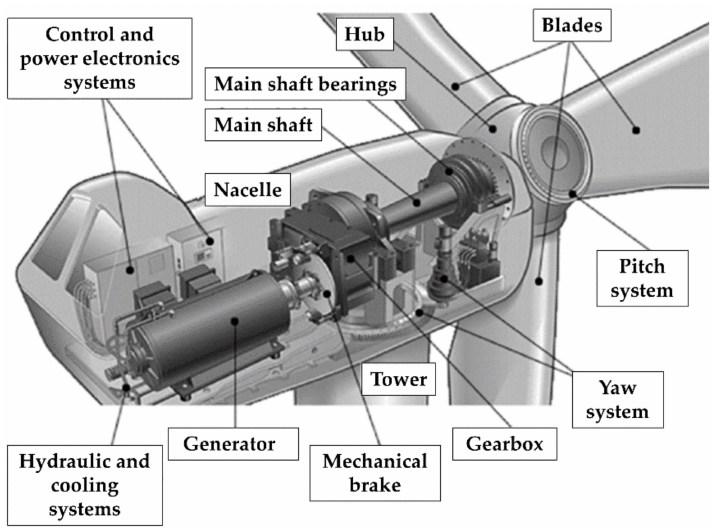
Figure 6. Mechanical and electrical components inside the nacelle of a conventional